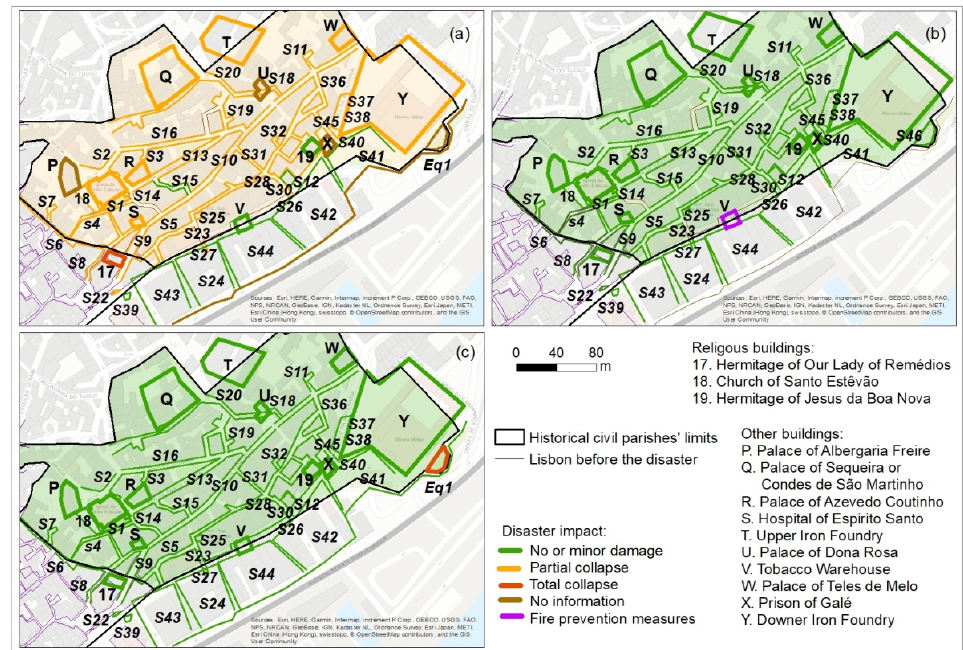
Figure 7. Overall disaster impact on Santo Estevão historical civil parish due to ( a ) earthquake; ( b ) fire; ( c ) tsunami. List of street names, land uses and equipment are indicated in Figure 4. The pre- sent-day layout of the city is presented on the background.